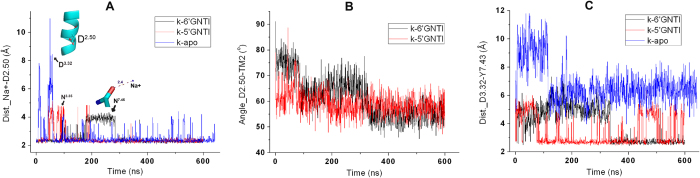
The evolutions of D1052.50 and 3-7 lock. (A,B) Evolution of the distance between Na+ and the conserved residue D1052.50 (A) or the angle between D1052.50 and TM2 (B). (C) Variation of the distance between the residue D1383.32 and Y3207.53.